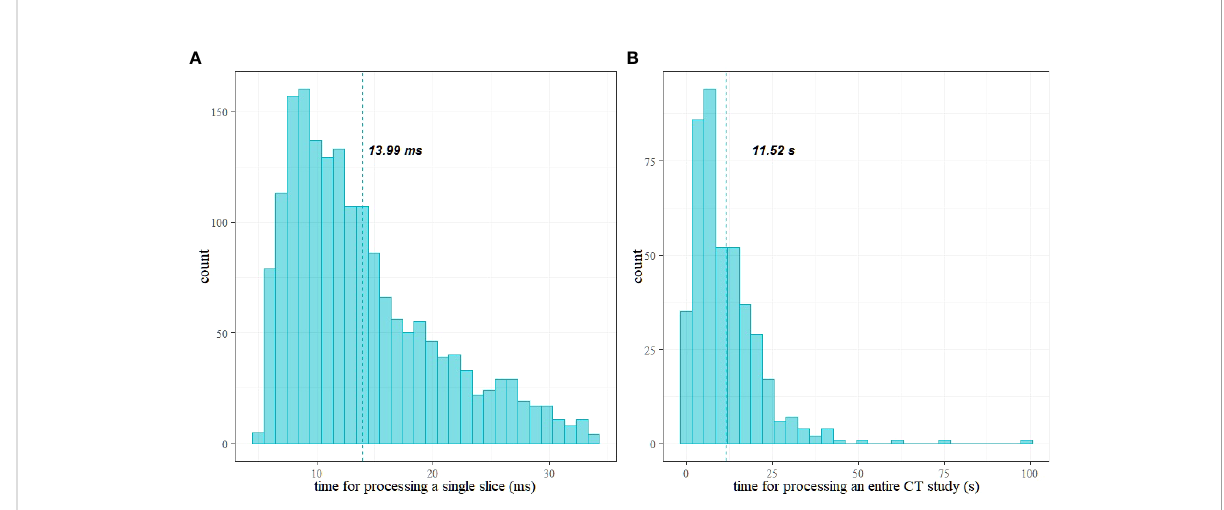
FIGURE 9 Histograms of time for processing: (A) a single CT slice and (B) a patient study; vertical lines show the mean values.